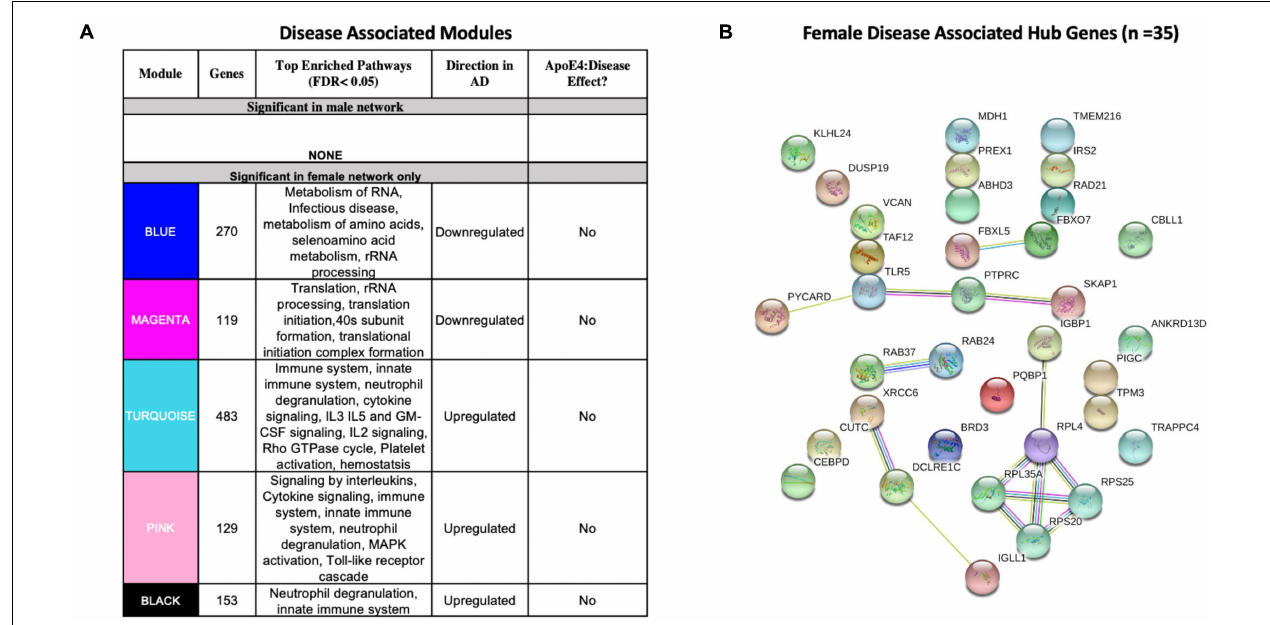
FIGURE 4 | Network analysis in whole blood. WGCNA was used to construct gene network separately for males and females in whole blood. Networks were randomly assigned colors. (A) A description of the disease-associated gene networks (termed modules) produced using WGCNA. Significant disease-associated modules were identified by associating module eigengene to case/control status adjusting for age and APOE ε 4 status and education ( P < 0.05). KEGG enrichment analysis of significant was conducted using an adjusted P- value threshold of 0.05. The direction in AD is computed using the case/control coefficient of the model associating module eigengene to case/control status. Modules with significant APOE ε 4 :disease interaction effect were identified by adding the interaction term APOE ε 4 :disease to the previous model ( P < 0.05). (B) Hub genes from female disease-associated modules. Hub genes were defined as genes with gene significance (the correlation between the gene expression and case/control status) greater than 0.2 and module membership (the correlation between gene expression and module eigengene) greater than 0.8. Hub genes were restricted to those that were differentially expressed in AD vs control. Protein-protein interactions between hub gene visualization was performed using the STRING v11 database. Edge color represents the type of interaction evidence for protein-protein interaction (cyan: known interaction from curated databases; turquoise: experimentally determined; green: gene-neighborhood predicted interaction; red: gene-fusions predicted interaction; blue: gene co-occurrence predicted interaction; green-yellow: text mining; black: co-expression; light purple: protein